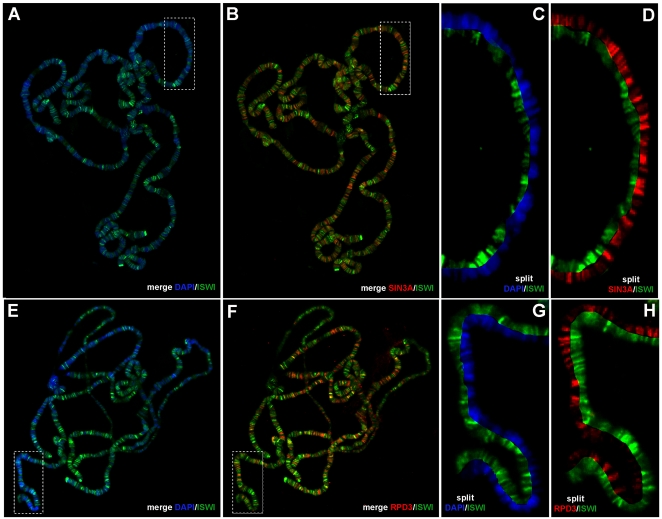
ISWI co-localize with Sin3A and Rpd3 at many sites on polytene chromosomes.(A, C, E and G) Distribution of ISWI and DAPI or (B and D) ISWI and Sin3A or (F and H) ISWI and Rpd3 proteins on salivary gland polytene chromosomes from wild-type third instar larvae. (C, D, G and H) Magnifications of boxed areas shown as “split” chromosome images. Displaying multiple staining patterns in a ‘‘split’’ format helps avoiding visual artifacts when high levels of one protein can mask low levels of another [37],[38]. ISWI, while present at varying abundances it co-localize with Sin3A and Rpd3 proteins at many sites on polytene chromosomes.